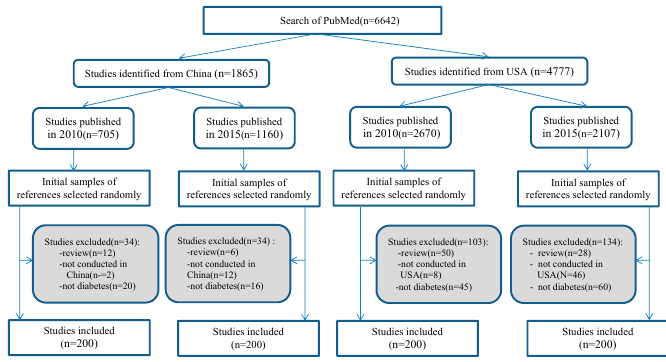
Figure 1. Selection process of relevant